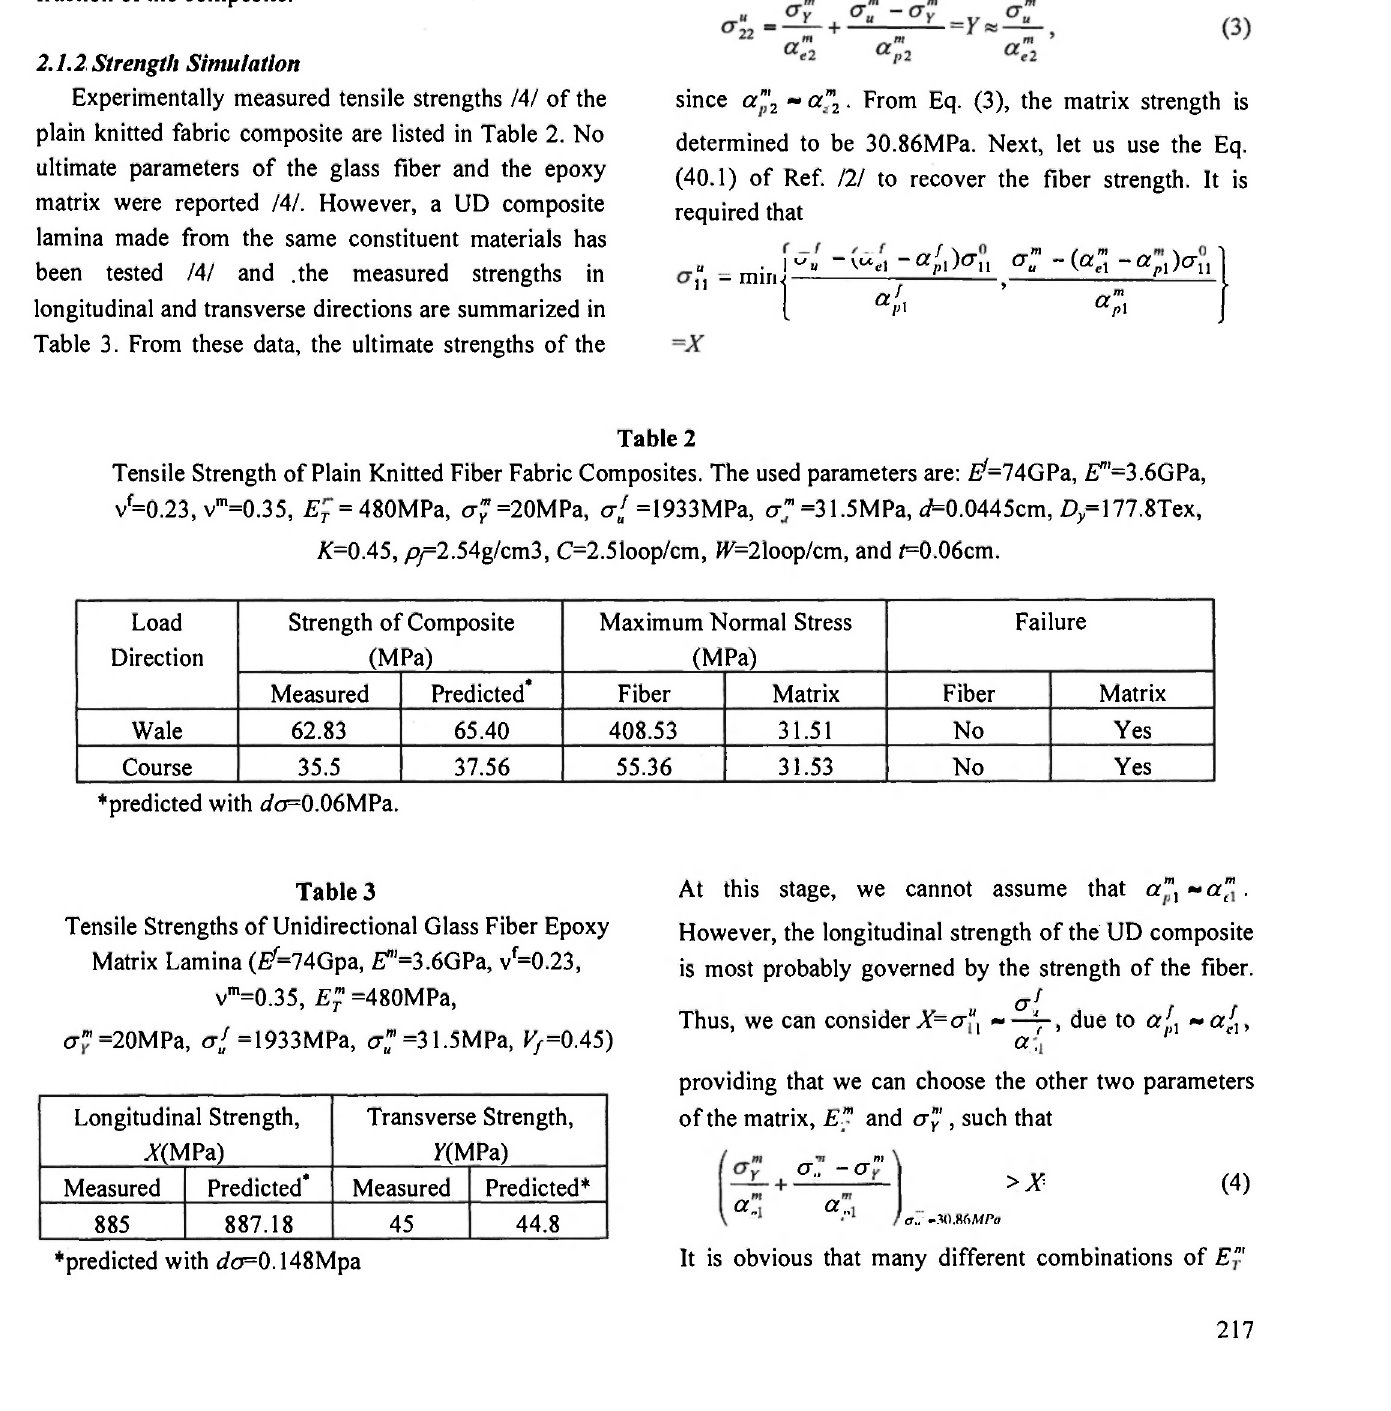
Tensile Strengths of Unidirectional Glass Fiber Epoxy Matrix Lamina (E f = 74Gpa, £ m =3.6GPa, v f =0.23, v m =0.35, Ε;